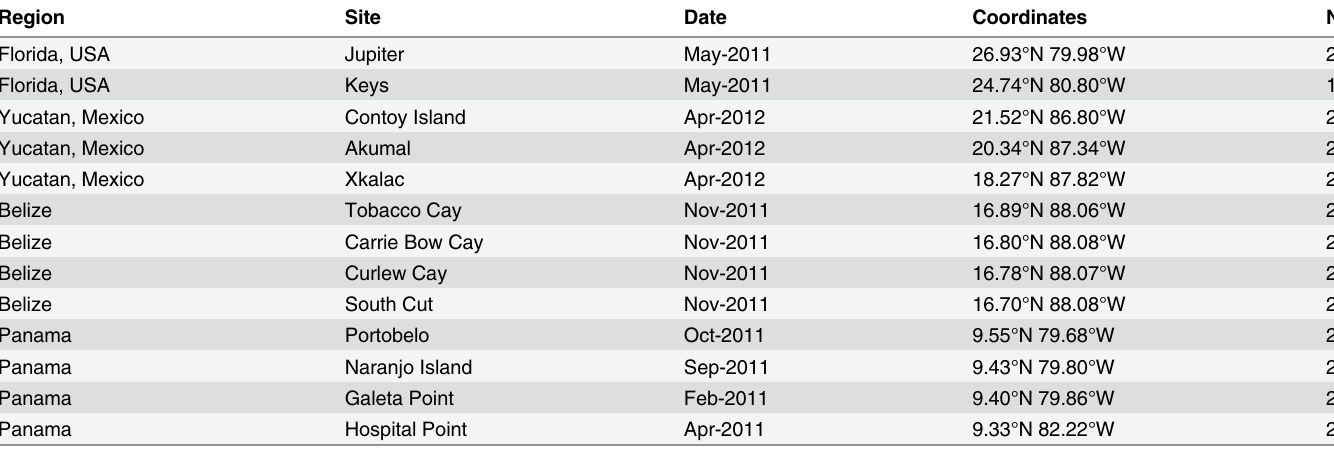
Table 1. Date, coordinates, and collection effort for each collection site in four regions for latitudinal survey of Pterois volitans parasites.